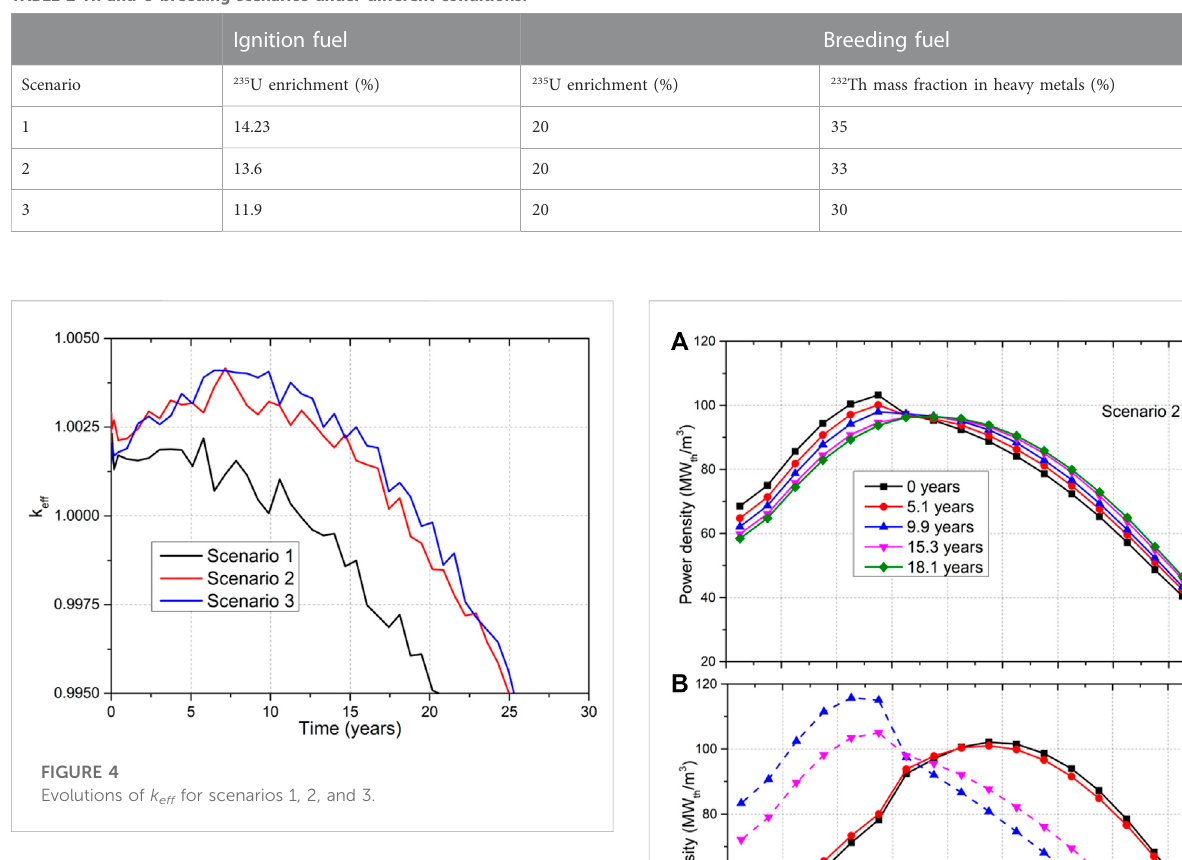
TABLE 2 Th and U breeding scenarios under different conditions.